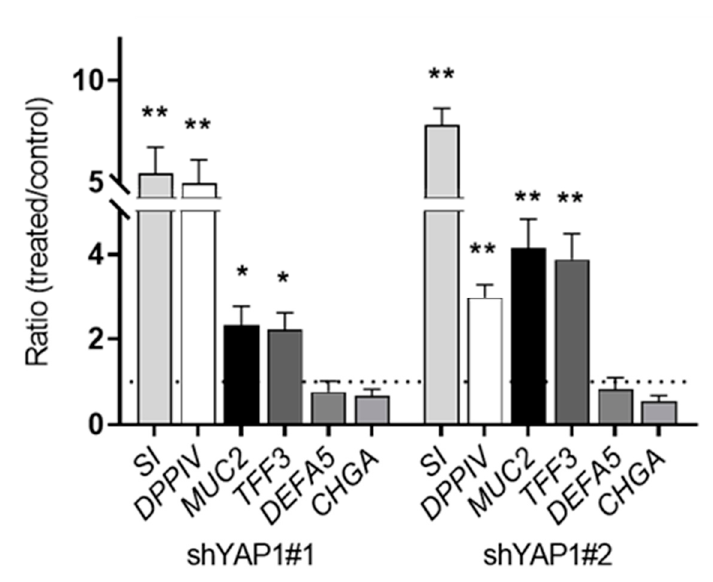
Figure 5. Expression of intestinal cell lineage markers in response to YAP1 knockdown. qPCR analyses of absorptive cell markers SI and DPPIV , goblet cell markers MUC2 and TFF3 , Paneth cell marker DEFA5 and enteroendocrine cell marker CHGA were analyzed in shYAP1#1 and shYAP1#2 expressing cells relative to shCtrl cells (dotted line). * p < 0.05, ** p < 0.005.